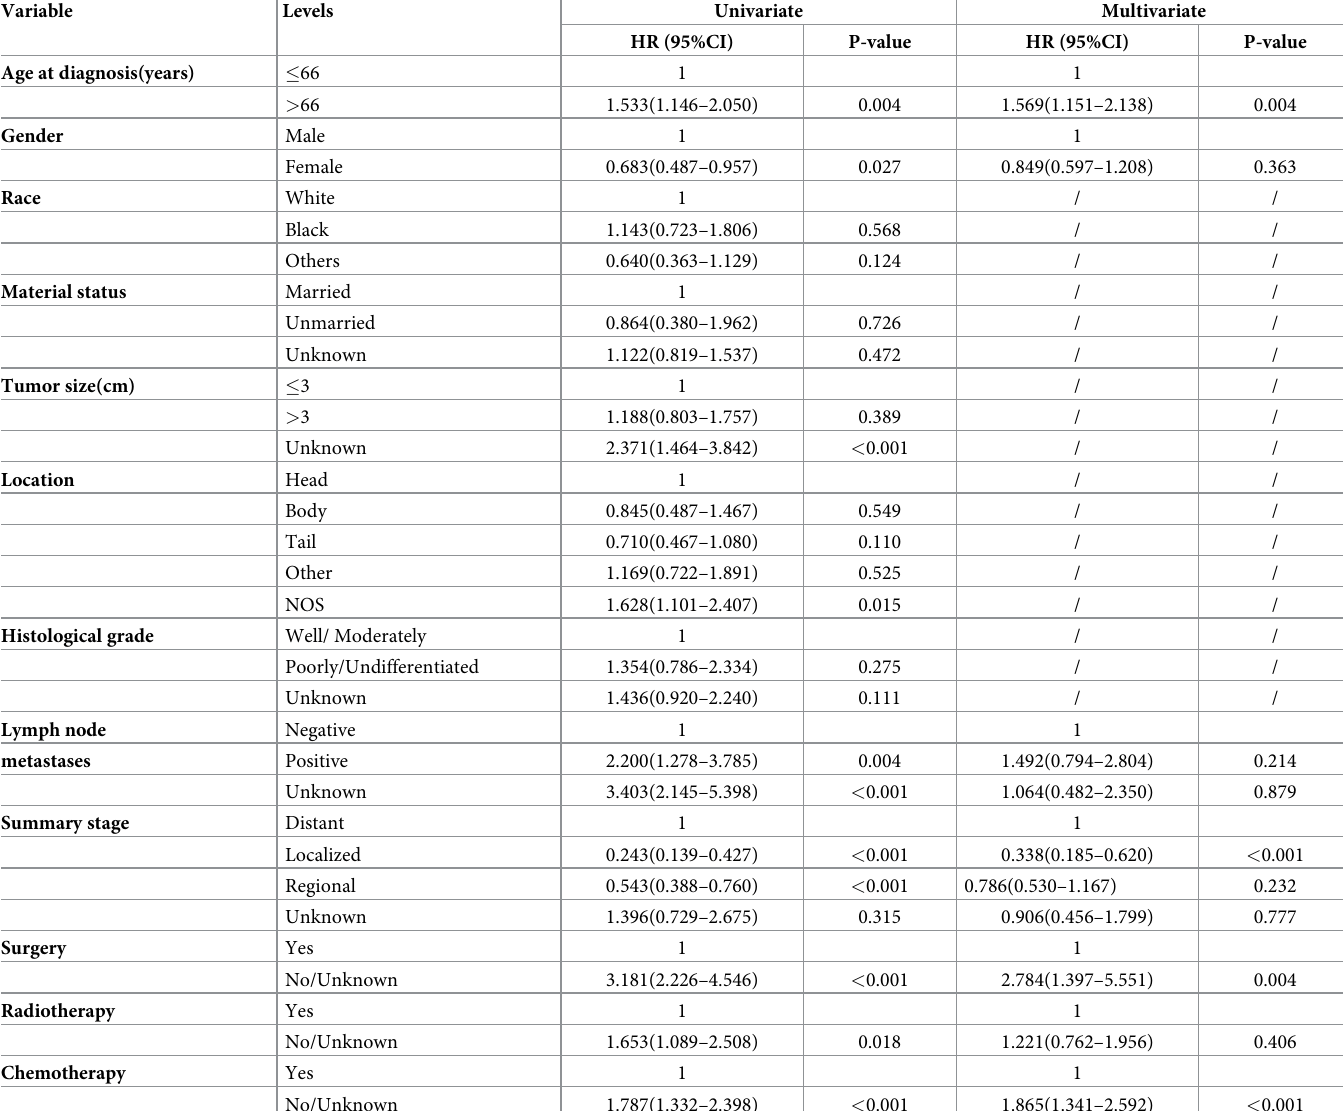
Table 4. Univariate and multivariate regression analysis of overall survival in patients with pancreatic acinar cell